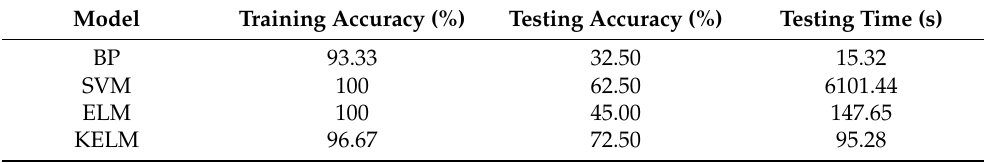
Table 1. Comparison of bearing fault diagnosis performance of various basic models.